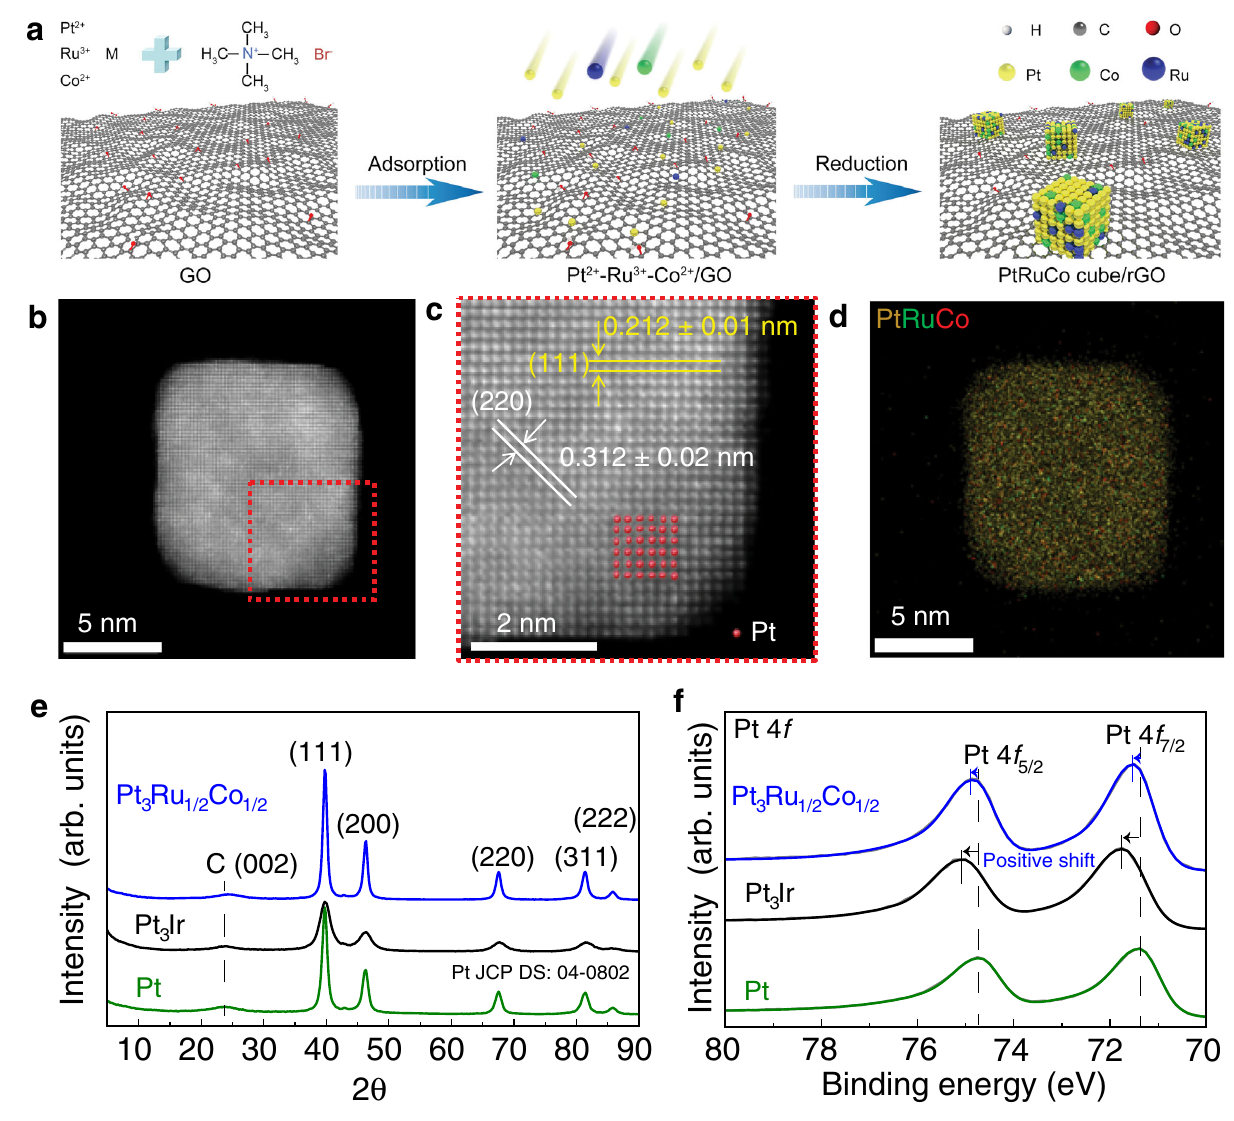
Fig. 3 | Structural and compositional analyses of Pt 3 Ru 1/2 Co 1/2 alloy electro- catalysts. a Schematic of the Pt 3 Ru 1/2 Co 1/2 ternary alloy synthesis, b – d HAADF- STEM images and the corresponding EDS elemental mapping of Pt, Ru and